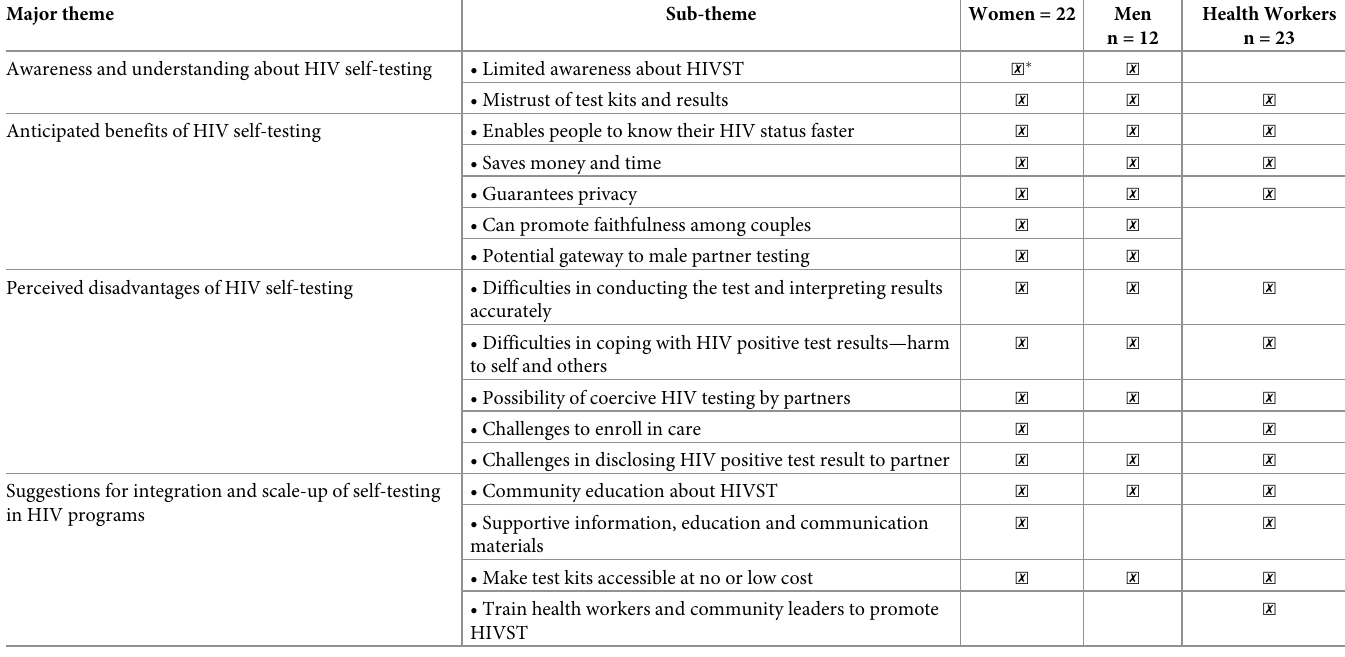
Table 1. Thematic presentation of women’s, men’s and health worker’s perceptions of HIV self-testing (n = 57); Kampala, Uganda. Major